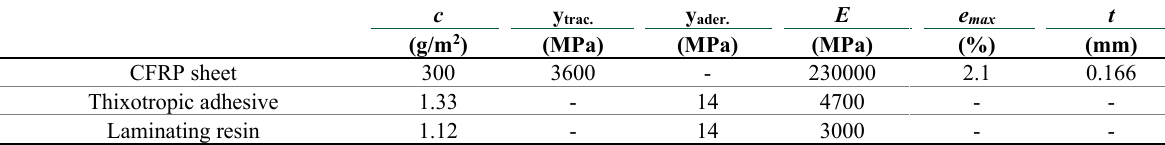
Table 4. Characteristics of materials employed in reinforcements with CFRP с у trac. у ader.